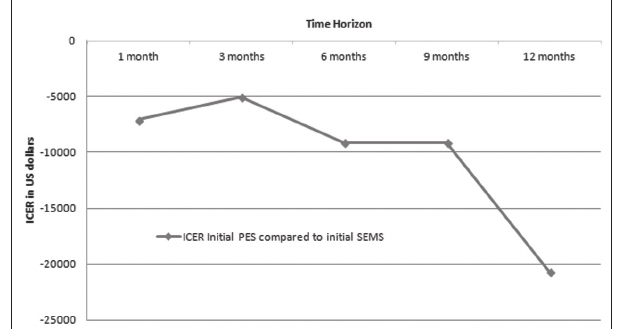
Figure 3) Incremental cost-effectiveness ratio (ICER) as a function of the adopted time horizon for the cost-effectiveness model. PES Polyethylene stent; SEMS Partially covered self-expandable metal stent